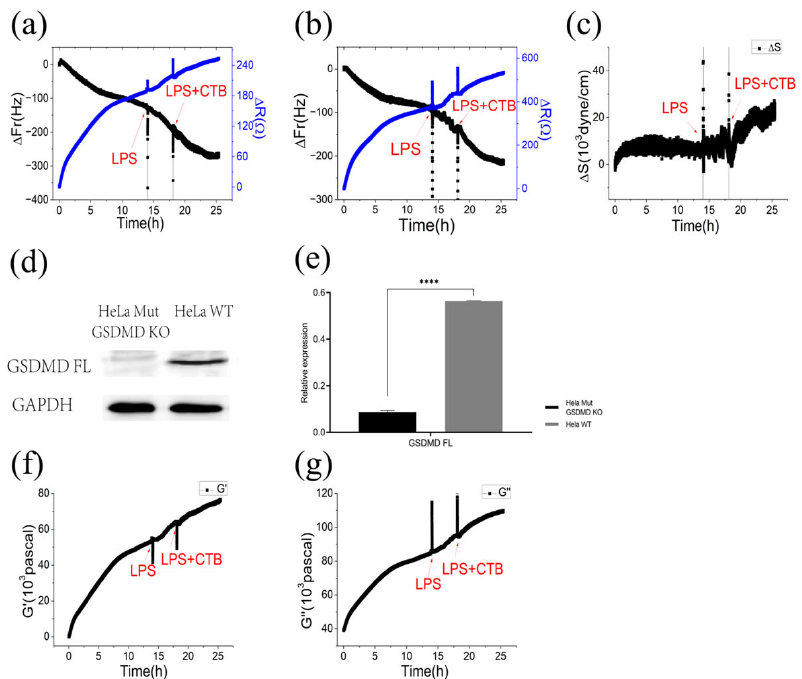
Figure 5. Dynamic QCM responses and cytomechanical parameters recorded during LPS and CTB induced pyroptosis ‐ resistance in 2000 GSDMD ‐ / ‐ ‐ DEVD ‐ mutant expressing HeLa cells. ( a , b ) Fre ‐ quency shifts and motional resistance changes on AT ( a ) and BT ( b ) cut quartz crystals; ( c ) Cells generated force on quartz crystal; ( d ) GSDMD knockout cells generated by CRISPR ‐ CAS9 ‐ mediated targeting, and its expression is verified through Western blot assay. The loading control is GAPDH expression; ( e ) The relative expression of target protein/GAPDH was analysed by Image ‐ Pro Plus 6.0 Software (**** p < 0.0001); ( f ) Variations in the elastic modulus (storage modulus) G ′ ; ( g ) Varia ‐ tions in the viscous modulus (loss modulus) G ″ .